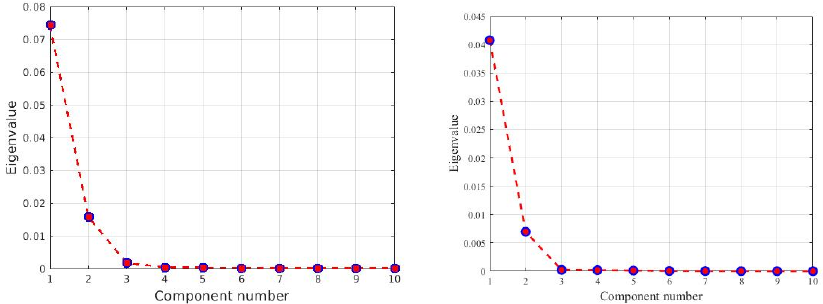
Figure 8. Scree plot of the contribution of each principal component bands for the two hyperspectral images in Figure 7 (Left Image 1 and Right Image 2).